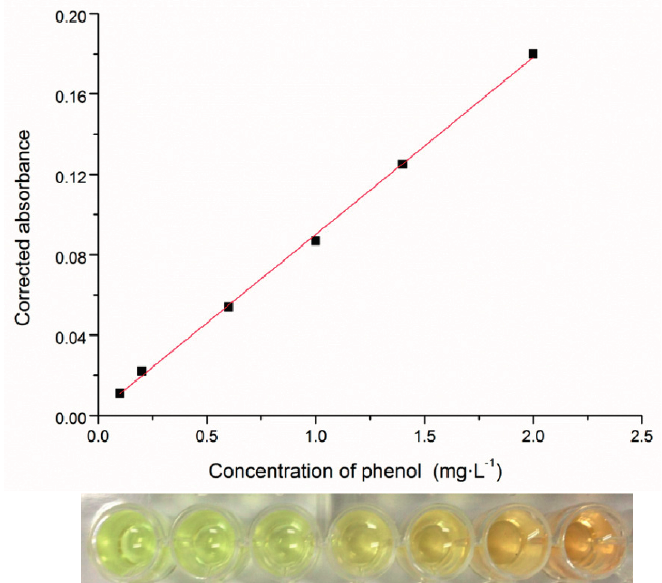
Figure 2. The correlation between phenol concentration and the absorbance of the generated indoxyl antipyrine in a 96-well microplate screening system ( upper panel); the color formation of indoxyl antipyrine at different phenol concentrations ( lower